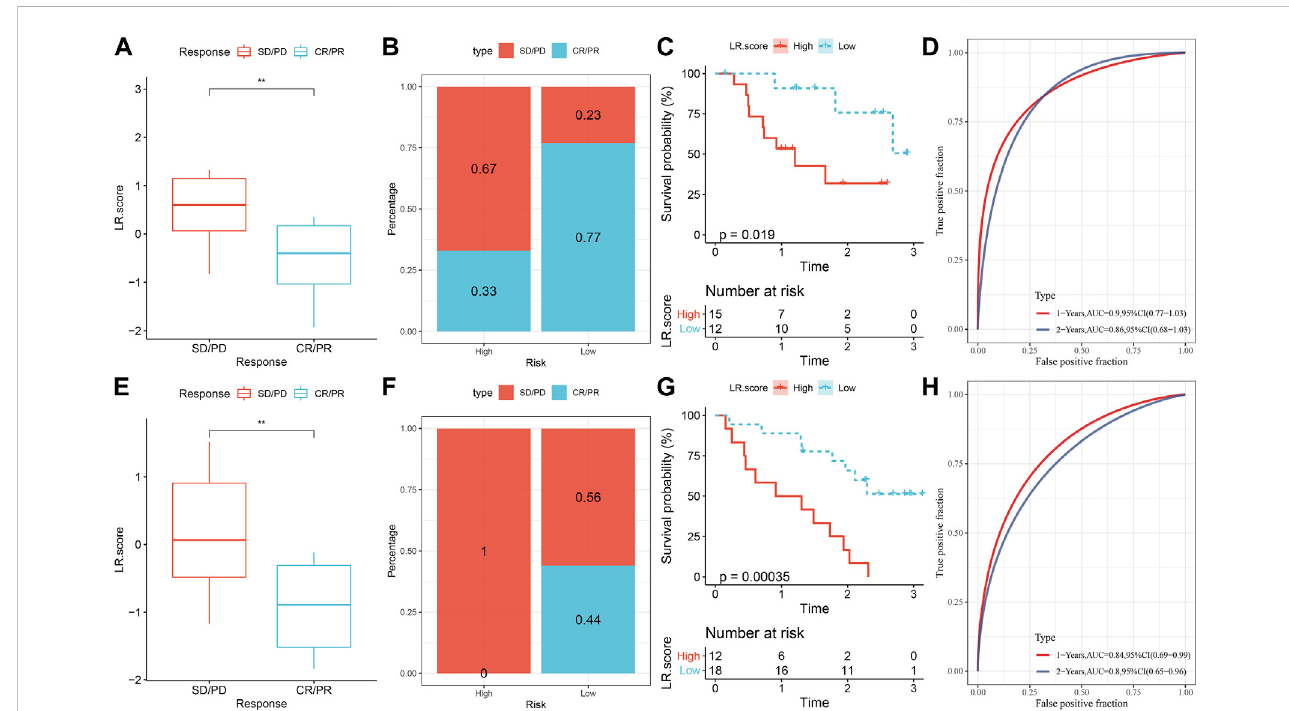
FIGURE 11 LR.score model to predicts the response to PD-L1 blockade immunotherapy. (A) Difference of LR.score between immunotherapy responses in GSE78220 cohort. (B) Distribution of immunotherapy response between LR.score groups in GSE78220 cohort. (C) Prognostic difference between LR.score groupsinGSE78220cohort. (D) ThepredictivevalueofLR.scoreinpatientsamongtheGSE78220cohort(AUC:0.9and0.86;1and2-yearsoverallsurvival). (E) Difference in LR.score between immunotherapy responses in the GSE91061 cohort. (F) Immunotherapy response distribution between LR.scoregroups in GSE91061 cohort. (G) Prognostic difference between LR.score groups in GSE91061 cohort. (H) The predictive value of LR.score in patients among the GSE91061 cohort (AUC: 0.84 and 0.8; 1 and 2-years overall